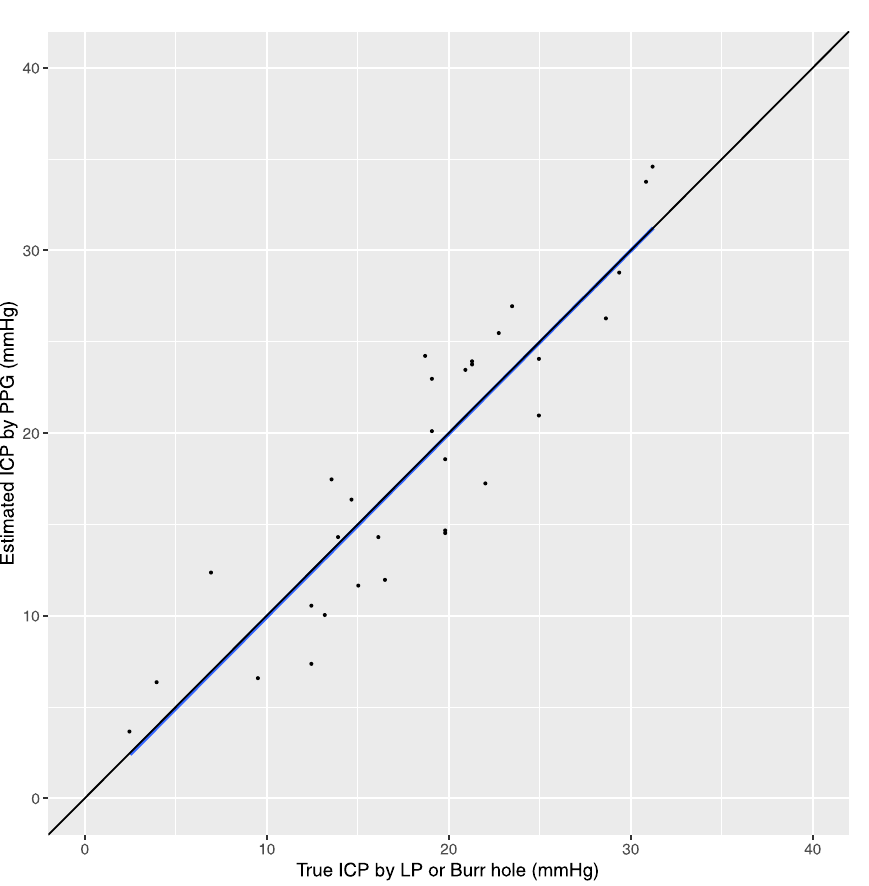
Figure 3. Association between ICP in mmHg measured by either external ventricular drain (EVD) or lumbar puncture (LP) and the estimated ICP calculated by photo-plethysmography (PPG). The line of best fit is shown in blue with the 95% confidence interval (shaded area). The line of perfect unity is also shown